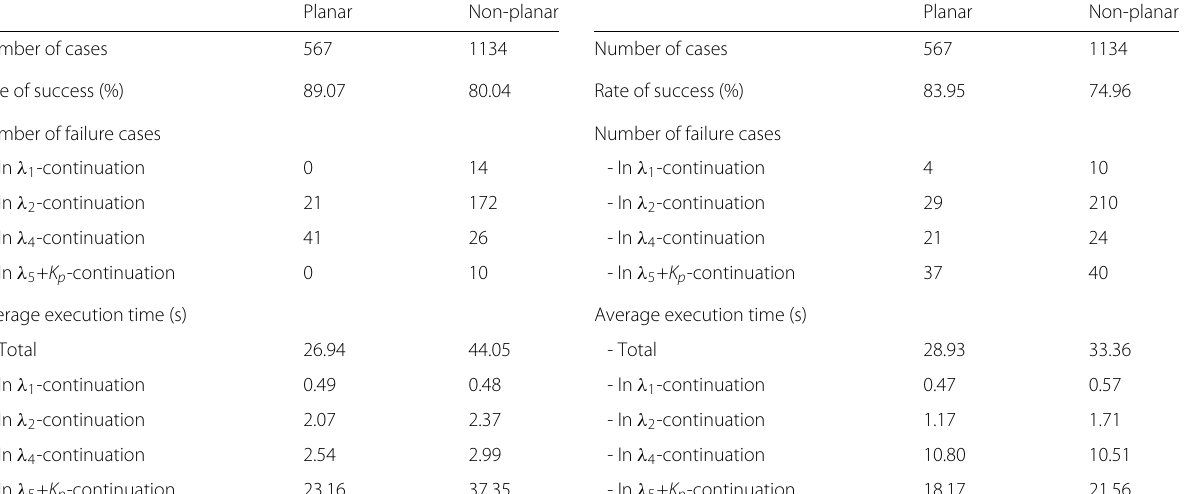
Table 3 Statistical results ( N = 2 and K = 8 × 10 2 ) Table 5 Statistical results ( N = 0 and K = 8 × 10 2 ) Planar Non-planar